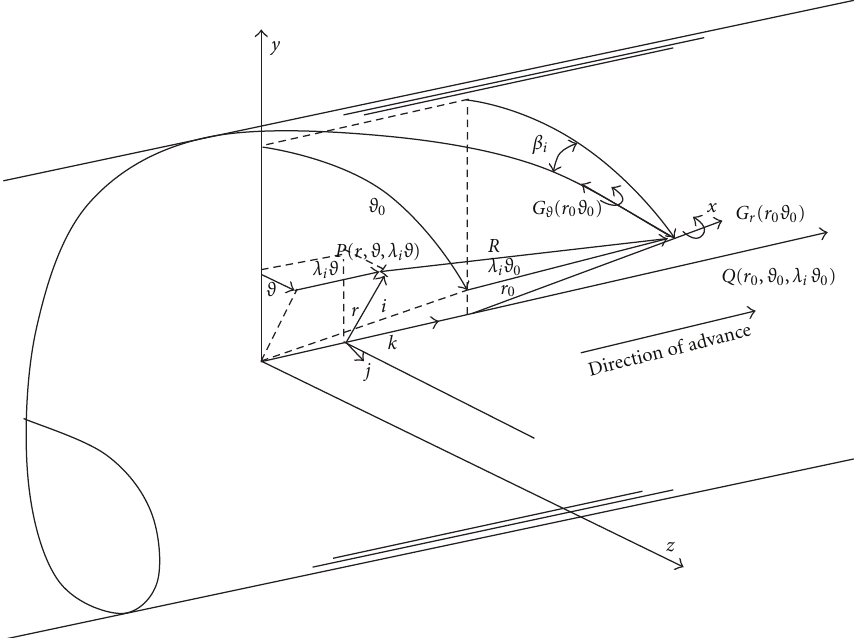
Figure 3: Reference system for bound and free